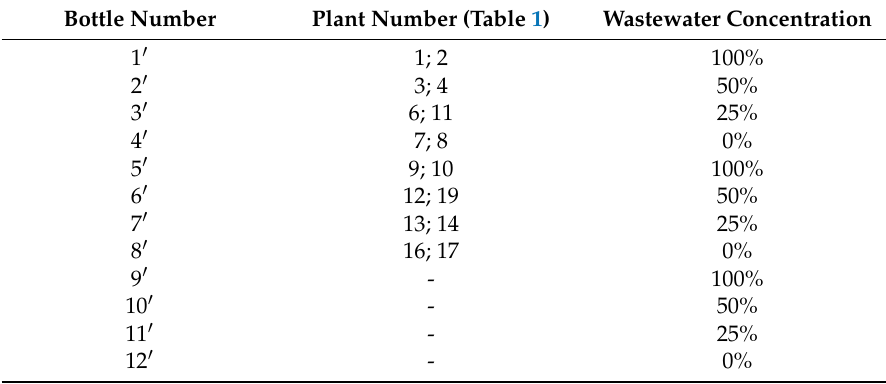
Table 2. The configuration of stage II of